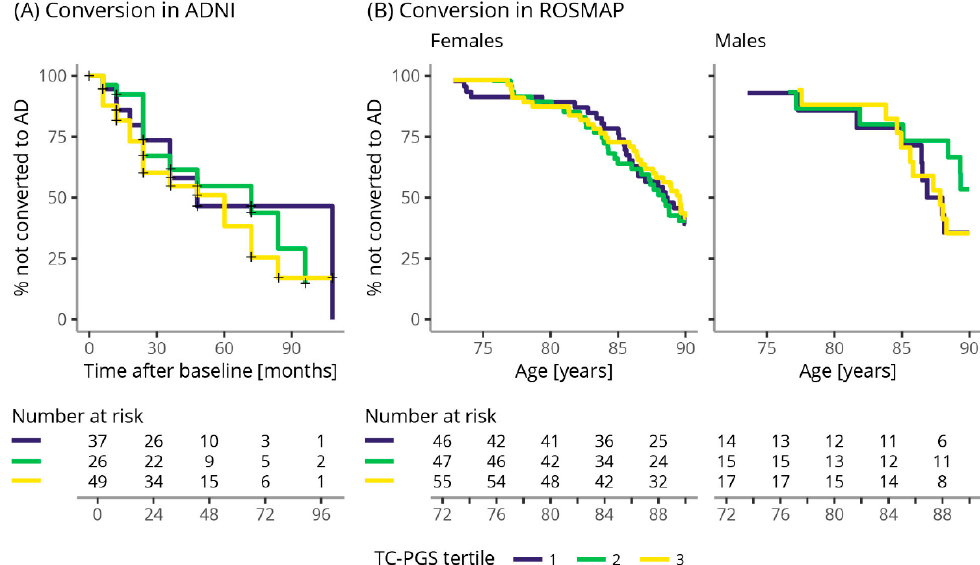
Figure 6. No effect of TC-PGS on AD conversion rate and age of onset. Kaplan–Meier survival curves displaying conversion rates to a clinical diagnosis of AD depending on TC-PGS tertiles in A β (+) individuals. ( A ) Conversion rate from healthy or MCI to AD as assessed by months after baseline visit in ADNI. ( B ) Conversion rate from healthy or MCI to AD as assessed by age in ROSMAP, stratified for sex. Abbreviations: AD, Alzheimer’s disease; TC-PGS, total cholesterol polygenic score.